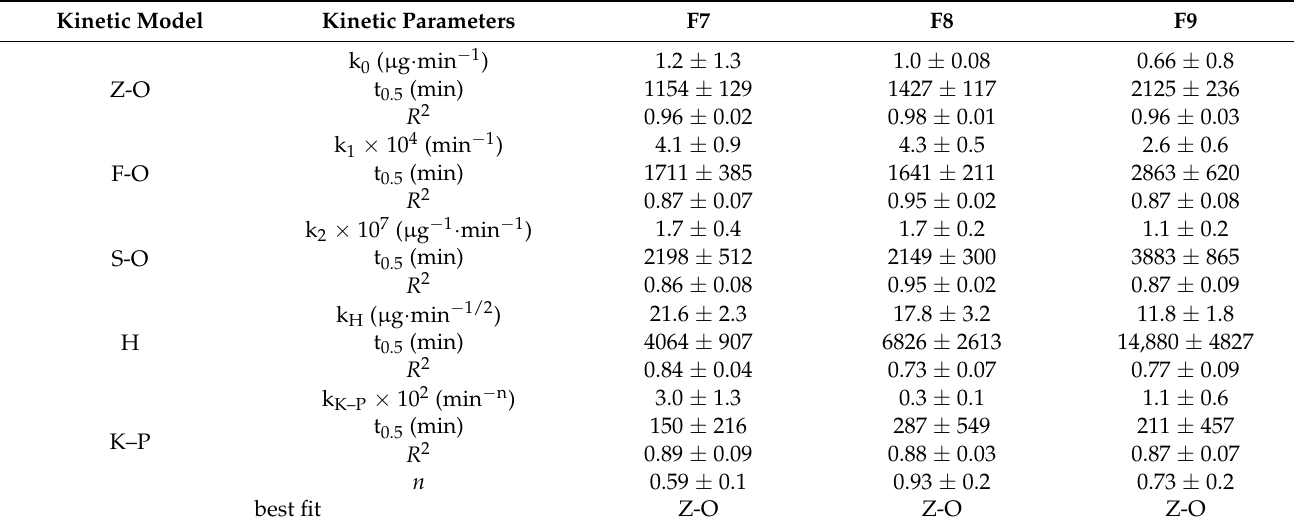
Table 4. The kinetic parameters of HA release from formulations F7–F9.